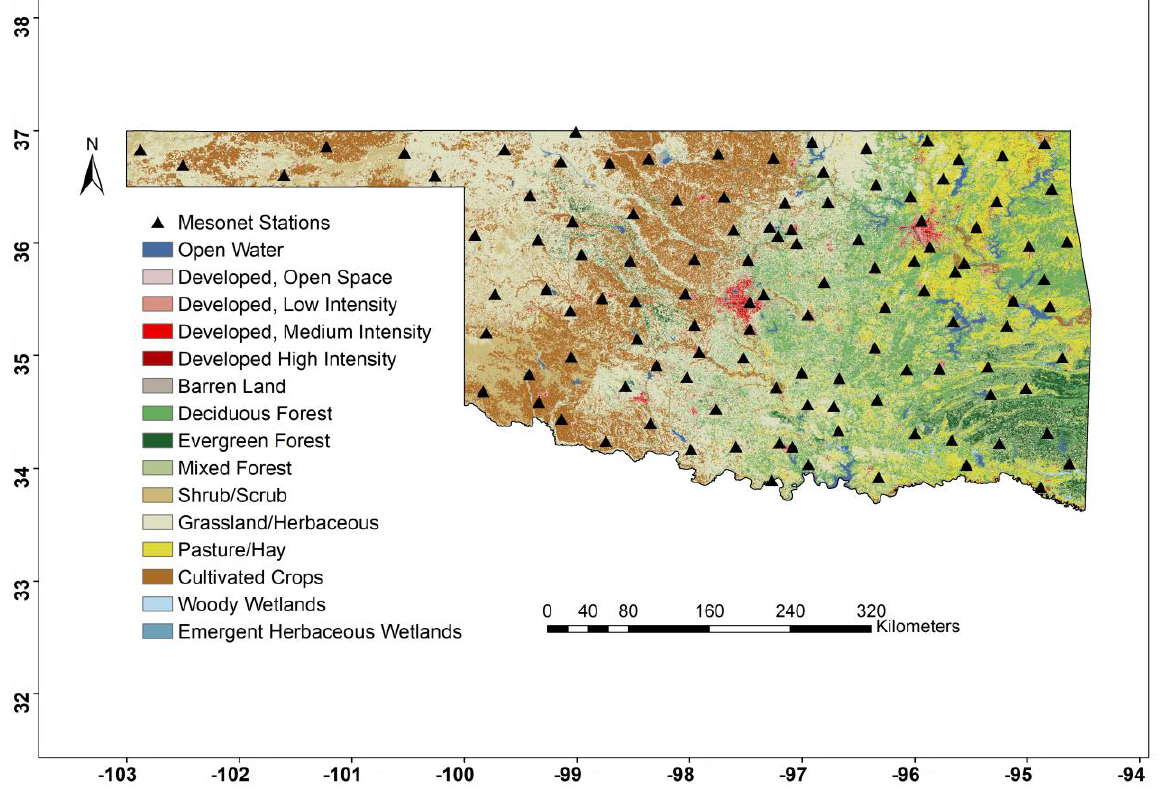
Figure 1. The distribution of in situ soil moisture stations from the Oklahoma Mesonet on a National Land Cover Dataset (NLCD) land cover type (for the year 2016) map. Geodetical coordinates (Lon, Lat) are also